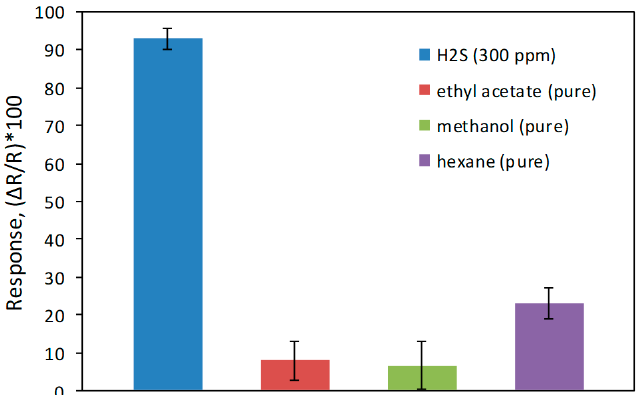
Figure 10. Selectivity test of electroactive PI / AuNPs with 300 ppm concentration of H 2 S, ethyl acetate (pure), methanol (pure), hexane (pure); (n = 3, RT).